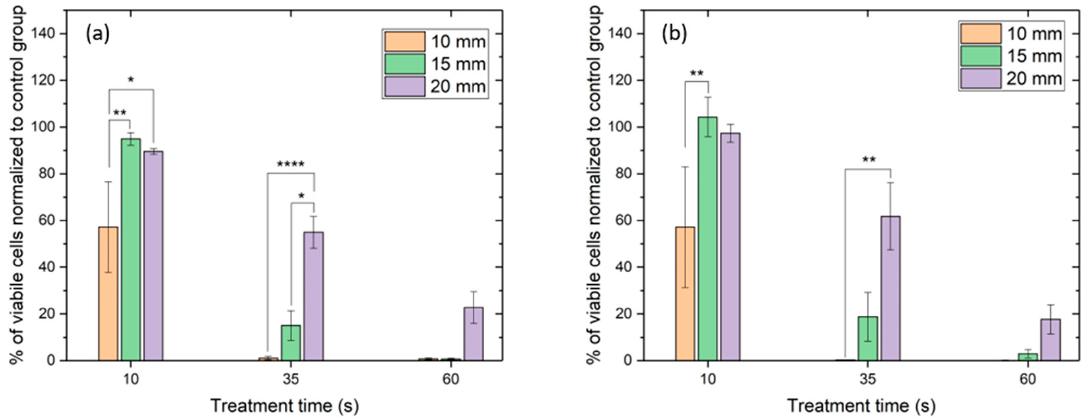
Figure 6. Cell viability test for 10 mm, 15 mm and 20 mm distance ( a ) 24 h and ( b ) 72 h after treatment. Results are presented as arithmetic mean ± SE. * p < 0.05; ** p < 0.01; **** p < 0.0001 (one-way ANOVA, Tukey test).